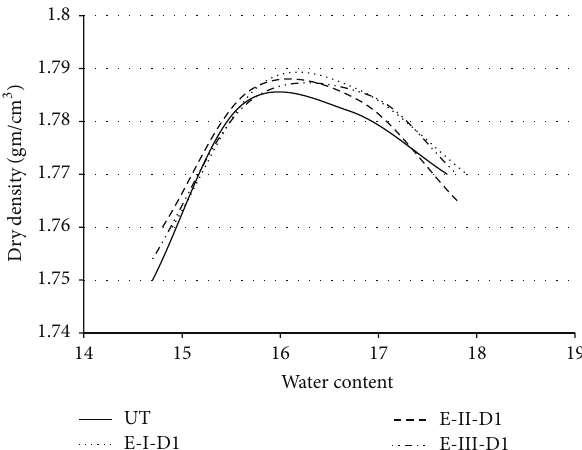
Figure 1: Compaction curves for untreated (UT) soil samples and soil treated with single dosage of the three different enzymes.